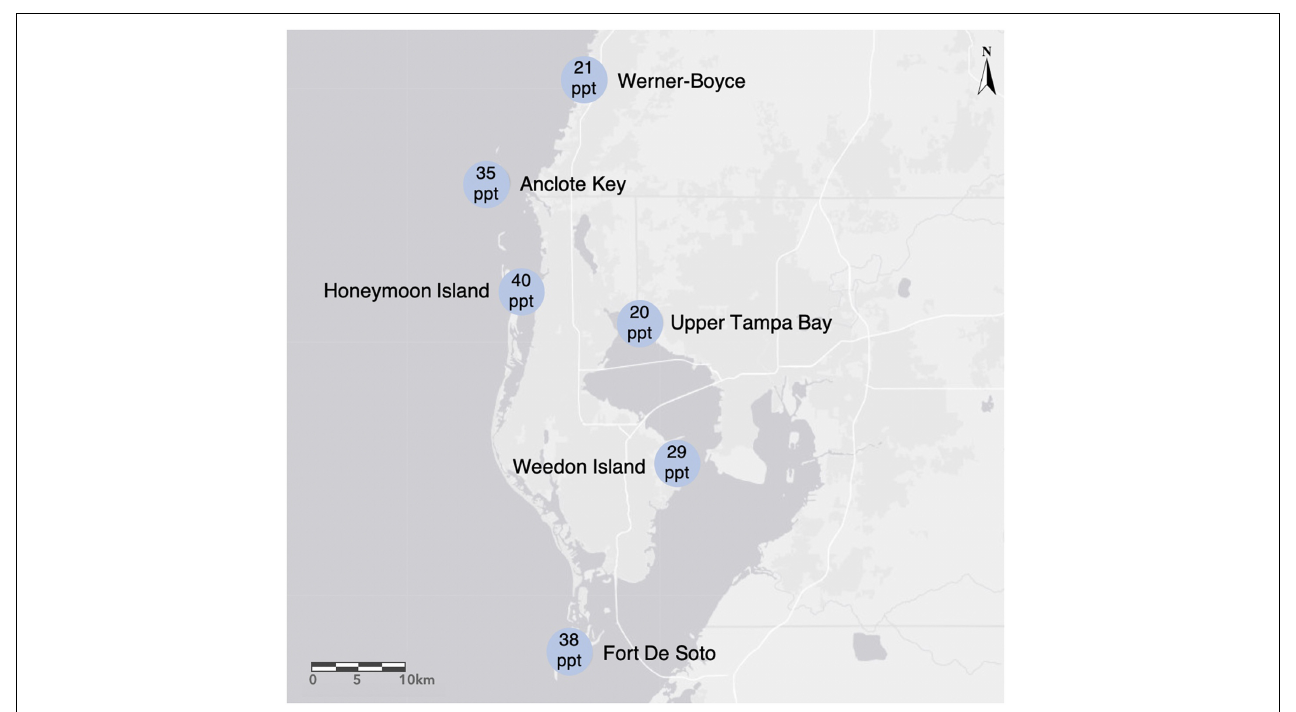
FIGURE 1 | We collected Rhizophora mangle propagules from the following sites in the Tampa Bay area on the west coast of Florida, USA: Werner-Boyce Salt Springs State Park, Anclote Key Preserves State Park, Honeymoon Island State Park, Upper Tampa Bay Hillsborough County Park, and Weedon Island Preserve Pinellas County Park. Salinity levels (ppt) on the date of collection for each site are indicated within the site location